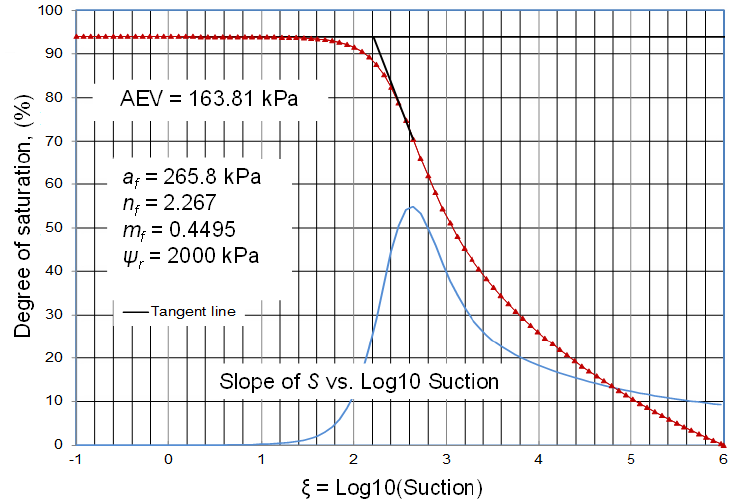
Figure 16. Calculation of the “true” air-entry value, AEV, for the soil using the transformed suction scale. ψ = any soil suction